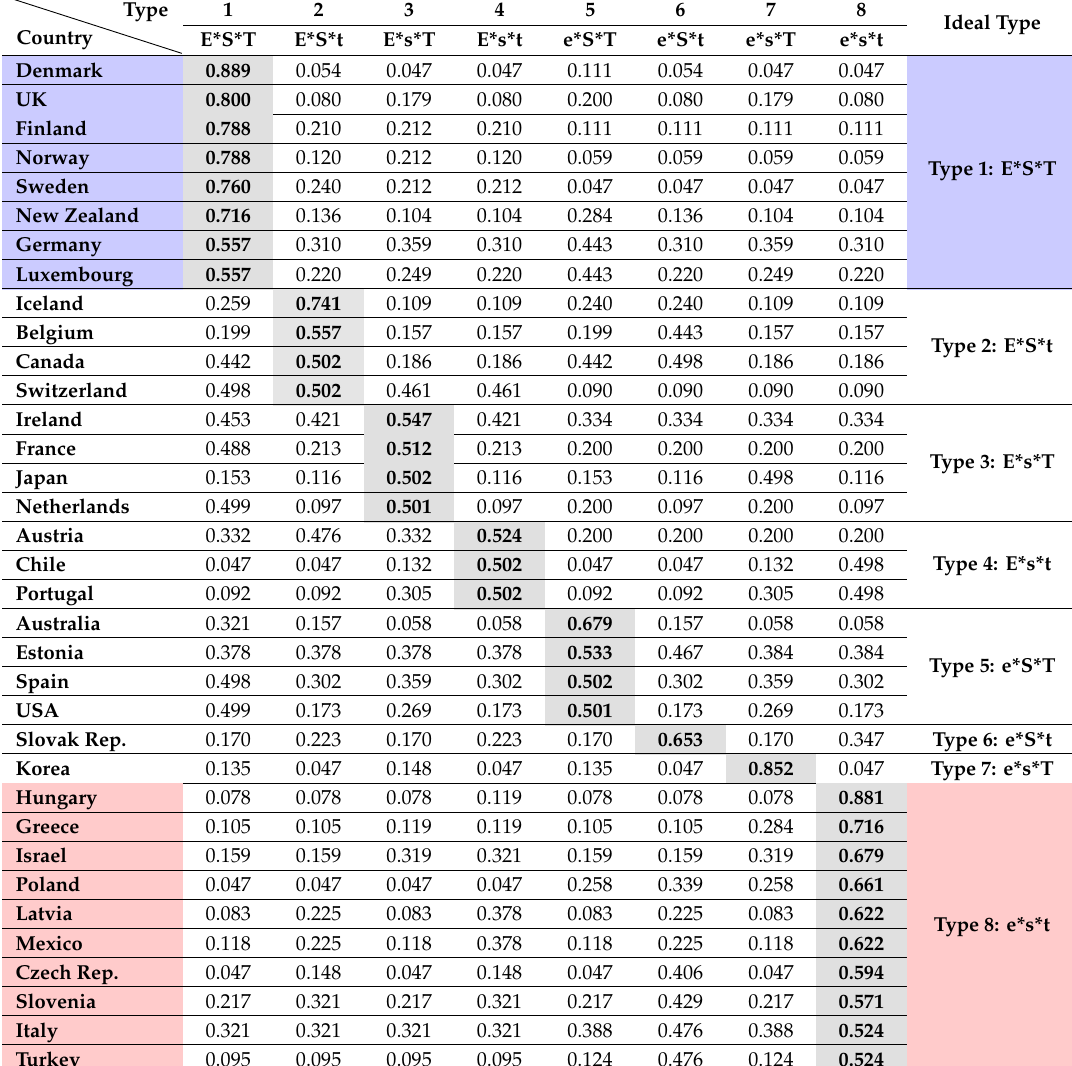
Table 3. Results of Fuzzy-set Ideal Type Analysis by OECD